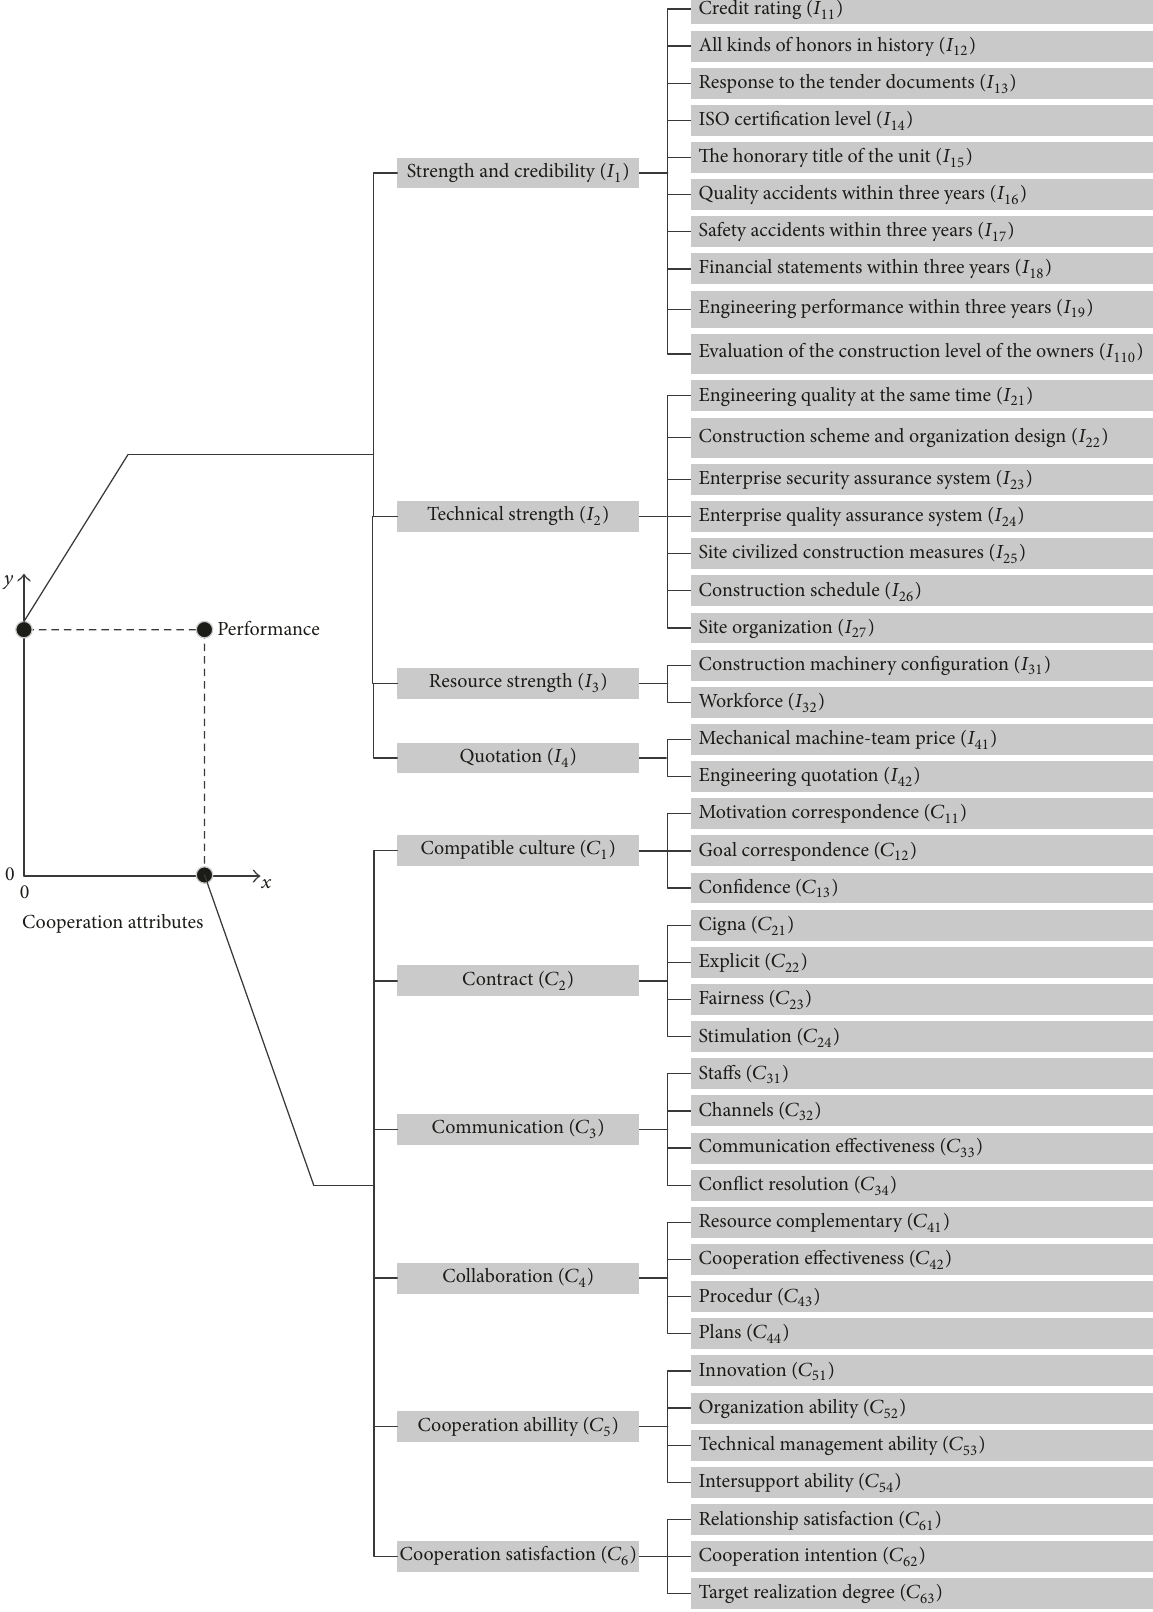
Figure 1: The evaluating attribute system of performance for joint venter